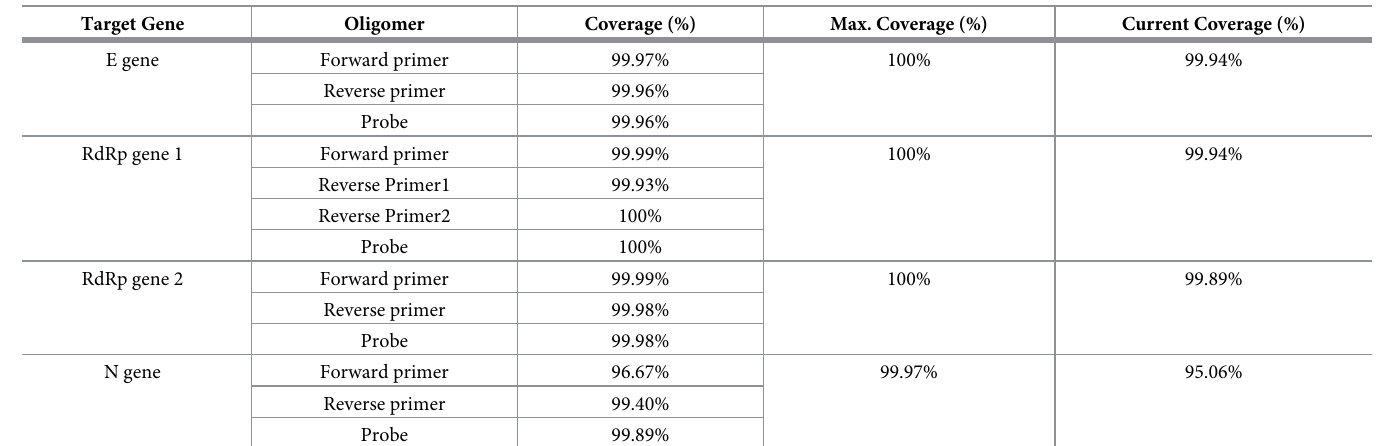
Table 1. The target genes and coverage of primer and probe of the AccuPower 1 kits. Target